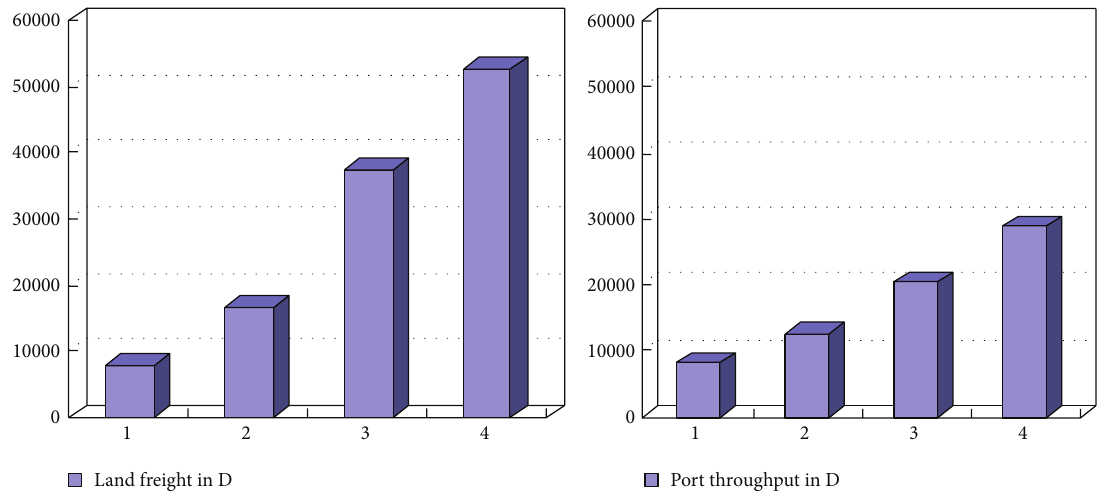
Figure 8: Freight volume of D in different